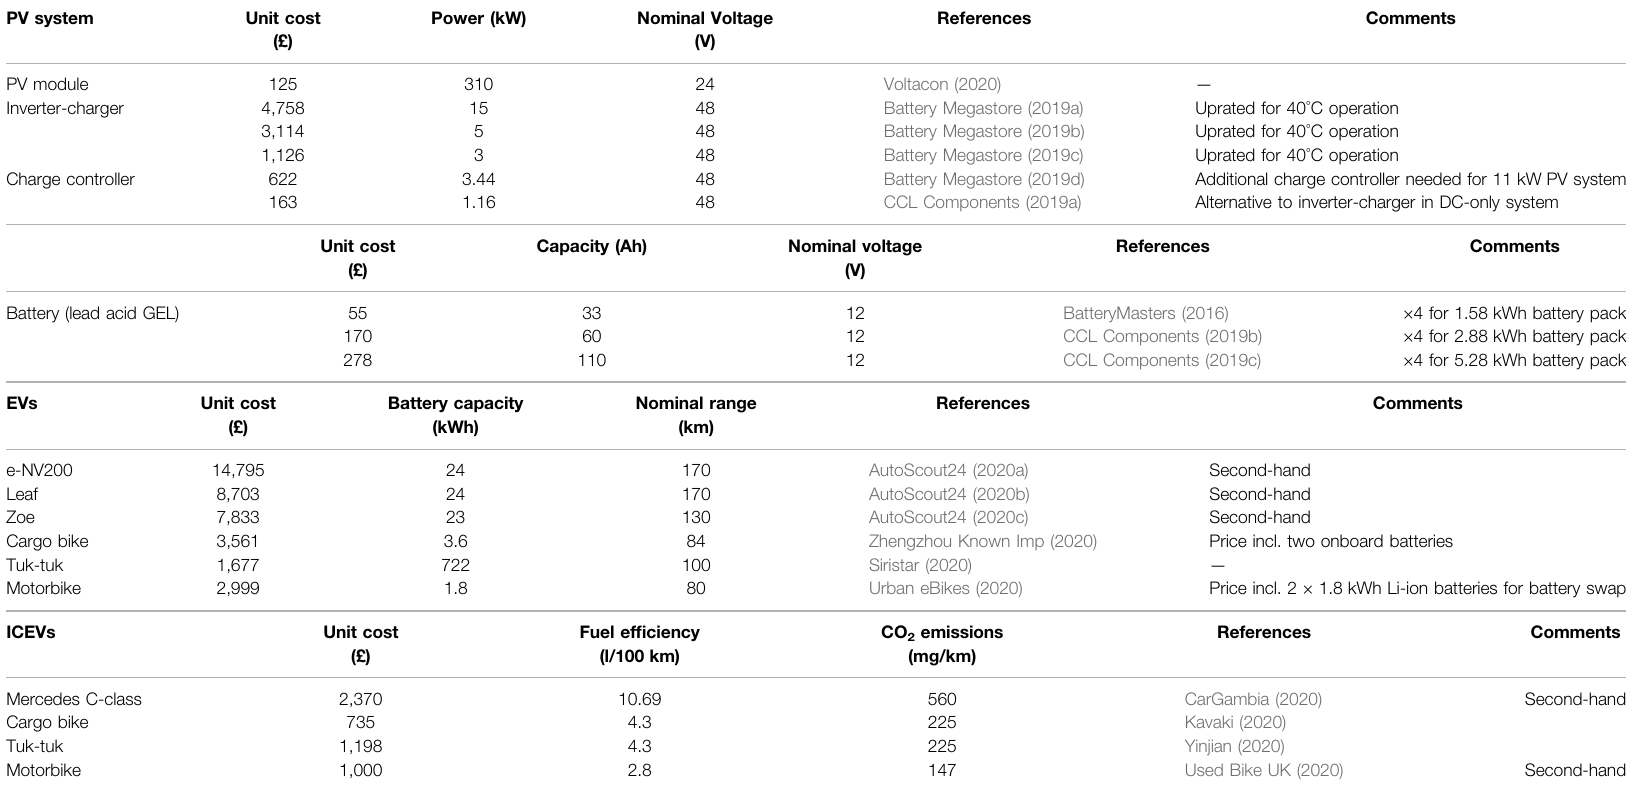
TABLE 2 | Key assumptions used in techno-economic